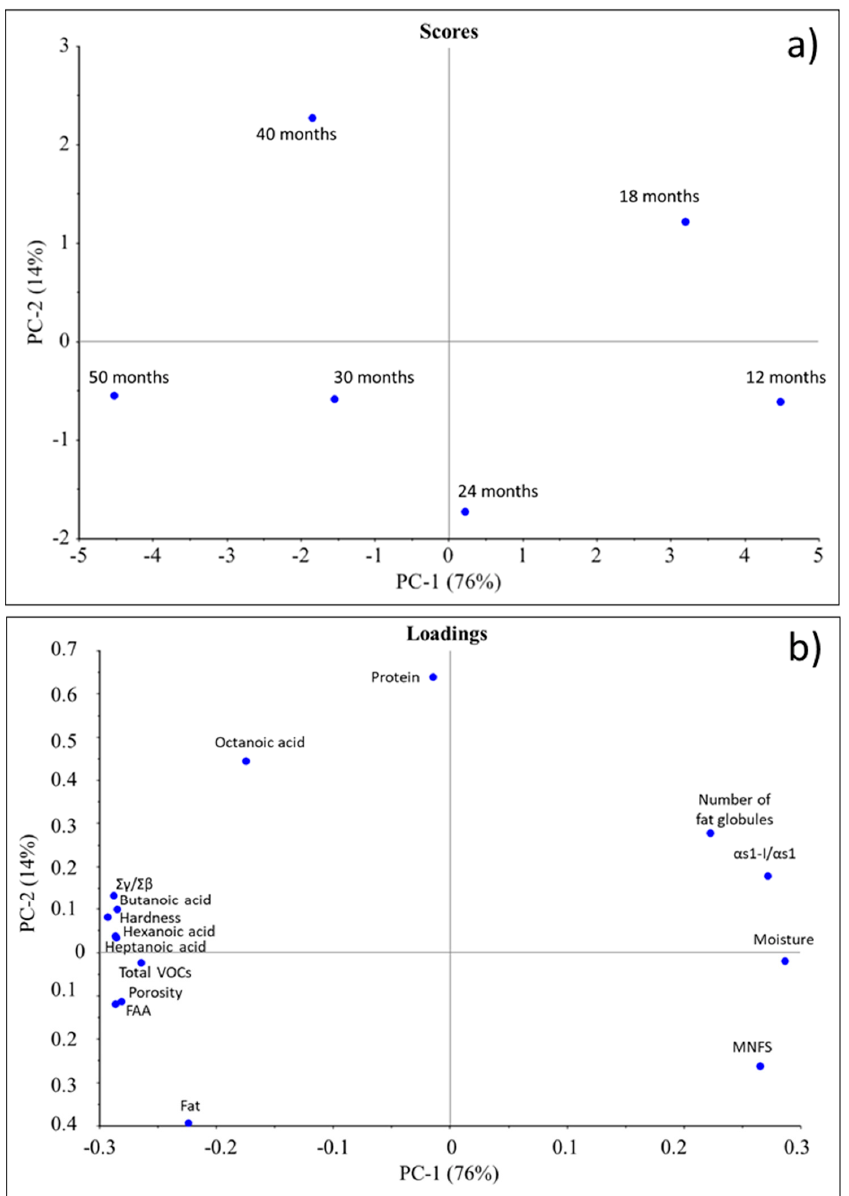
Figure 4. Principal component analysis ( a ), and loadings ( b ) of selected parameters evaluated in Parmigiano Reggiano cheeses ripened up to 50 months.